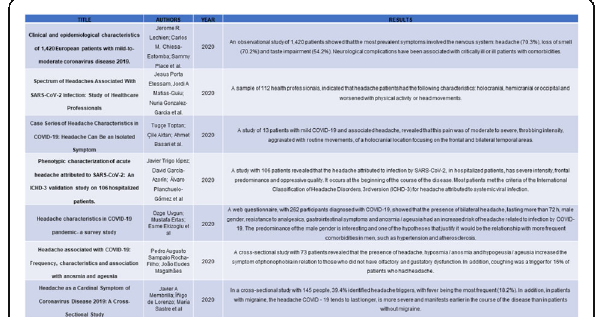
Table 2 (abstract P0173). See text for